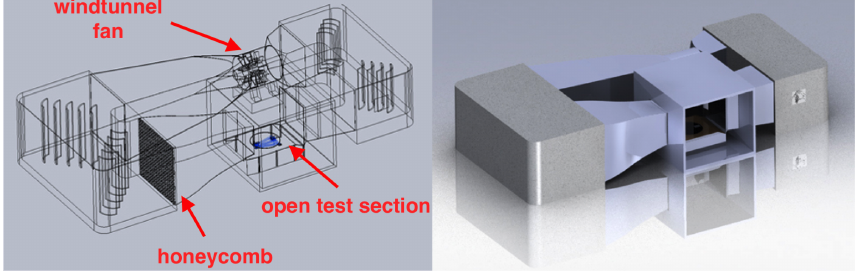
Figure 2. A sketch of the wind